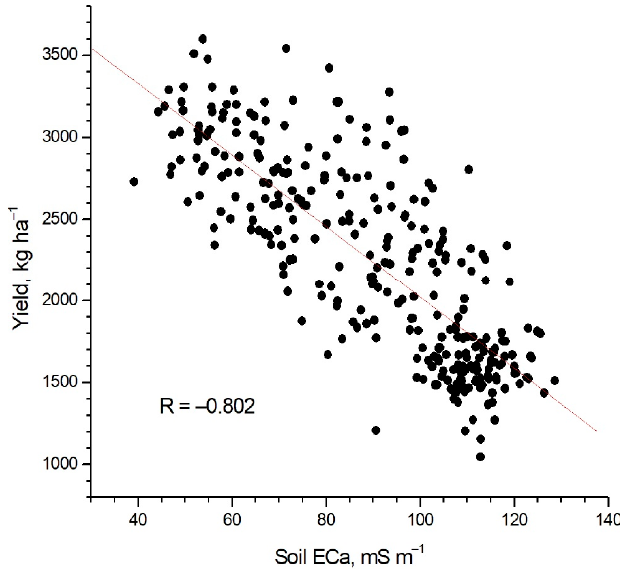
Figure 10. Relationship between soil ECa and final yield.